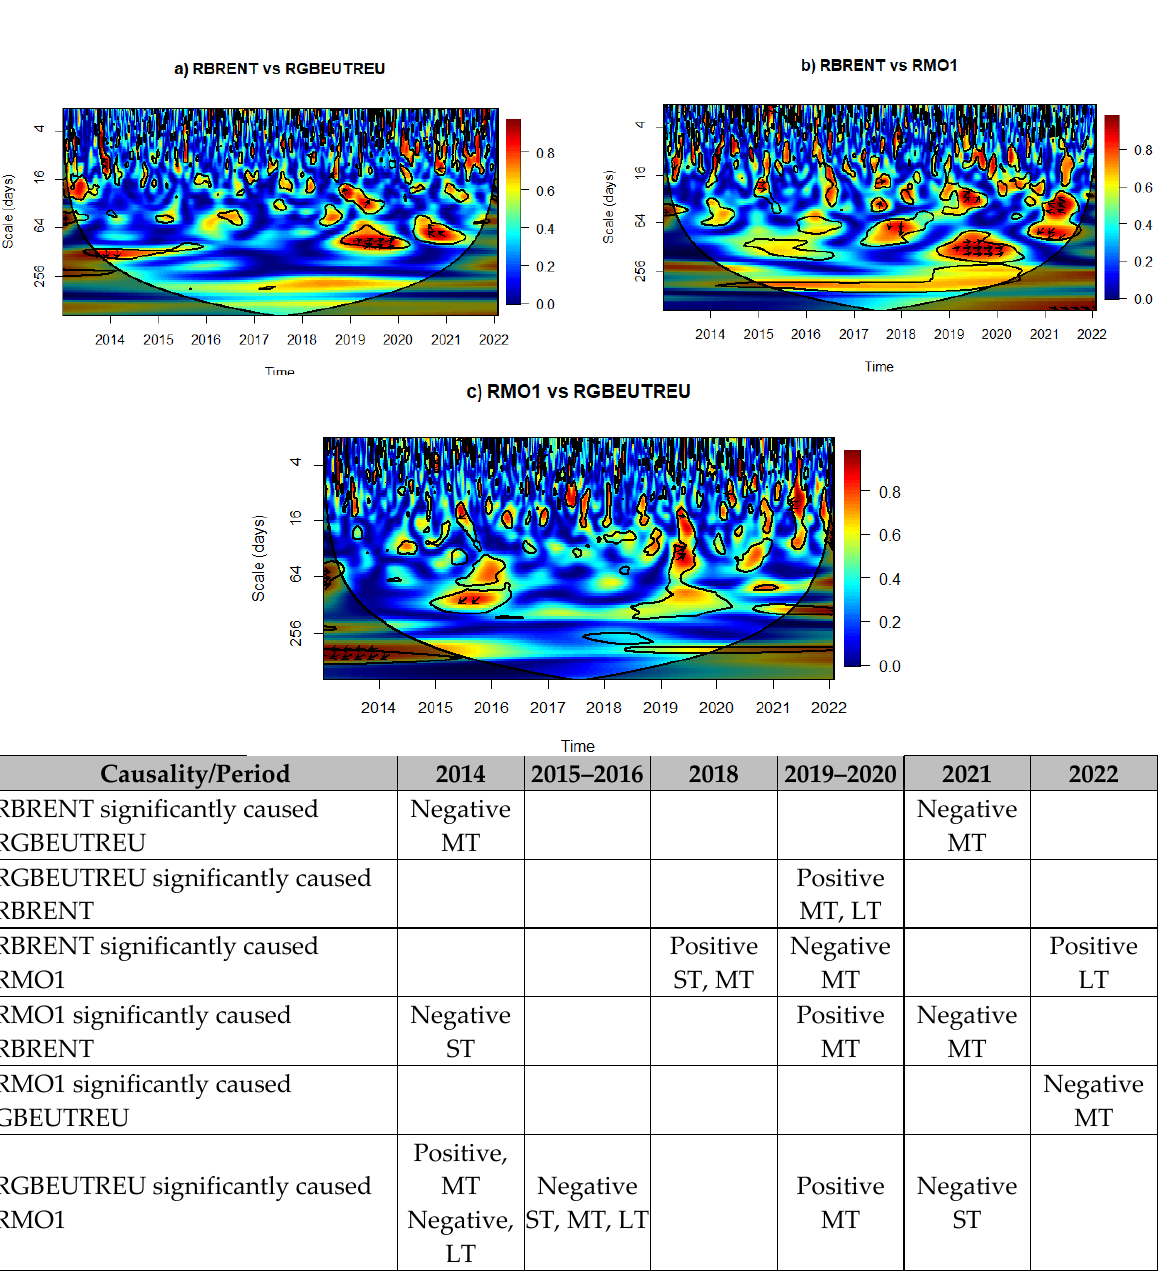
Figure 7. Wavelet coherence among Brent oil returns (RBRENT), CO 2 futures’ returns (RMO1), and Green Bond Index (RGBEUTREU). Source: Authors’ own research using data from Bloomberg. Note: The value of squared wavelet coherence is depicted in color, and the value of relative phase by arrows. The color code for the coherence ranges from blue (low coherence—close to zero) to red (high coherence—close to one). The area affected by edge effects is the semi ‐ transparent region at the left and right boundary separated by the black U ‐ shaped curve, which is the cone of influence (CoI). The thick black contours within CoI are the regions of significant coherence (at 5% level). The direction of the arrows reveals the phase relationship between each moment pair of times series returns in the time ‐ frequency space. Notes: ST: short ‐ term, MT: medium ‐ term, LT: long ‐ term.